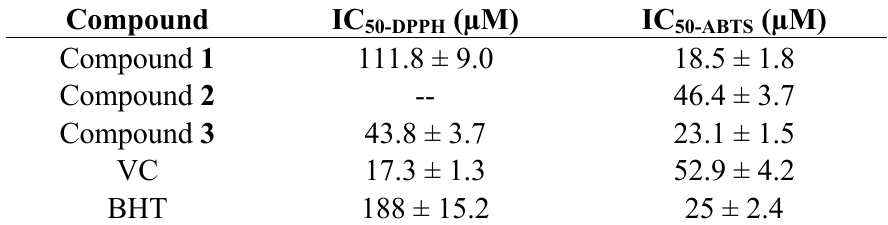
values of the antioxidant activities of compounds 1 – 3 Table 3. IC 50